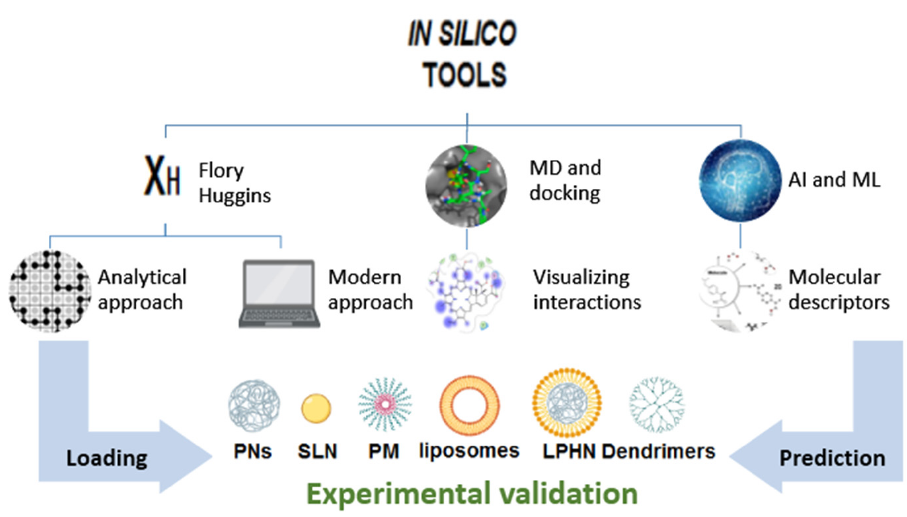
Figure 1. Contribution of different analytical and in silico tools to the drug loading optimization in different classes of nanocarriers.